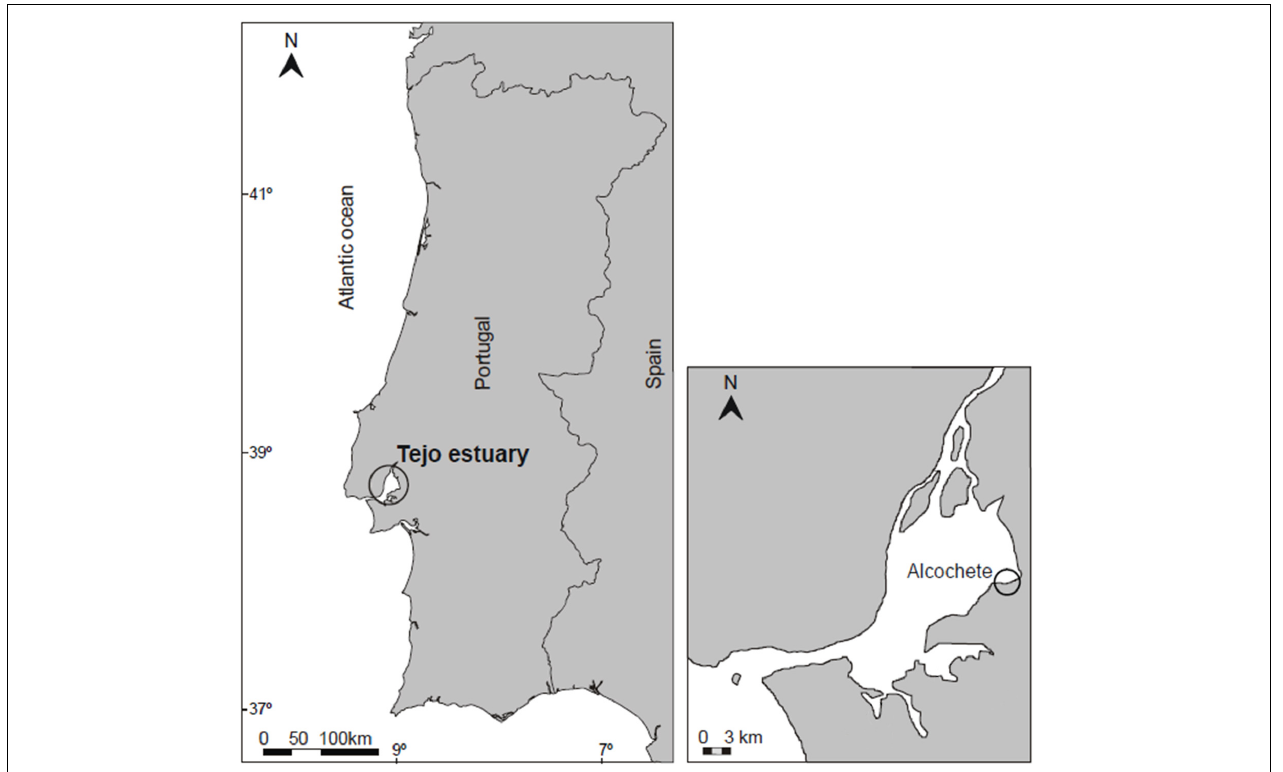
FIGURE 1 | Map of the location of the sampling site in the Hortas salt marsh (Alcochete) in the Tagus estuary.